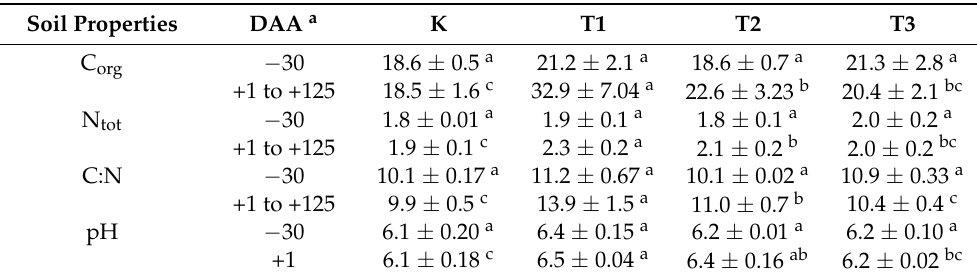
Table 4. Soil organic carbon (C org ) [mg g − 1 ], total nitrogen (N tot ) [mg g − 1 ], C:N ratio and pH before ( − 30 DAA a ) and after (mean: +1 to +125 DAA a ) BC-compost and mineral N application in 2014. Treatments are control (K) and three BC-compost treatments (T1, T2, and T3). For application rates of BC-compost and mineral fertilizer see Table 1. DAA